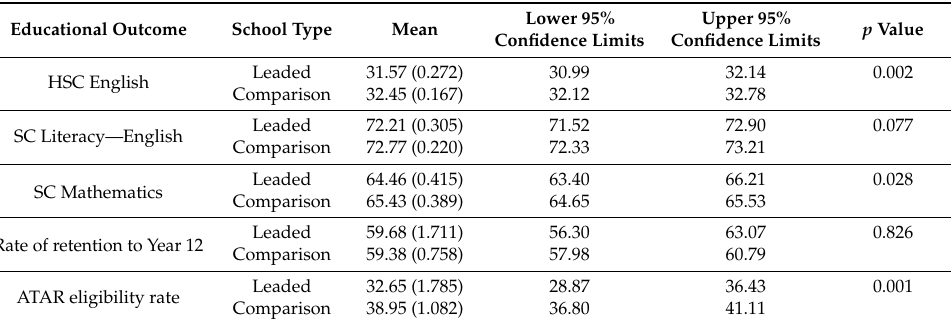
Table 3. Summary of the effect of lead on five educational outcomes. Mean, with standard error in parentheses, and 95% confidence intervals for the